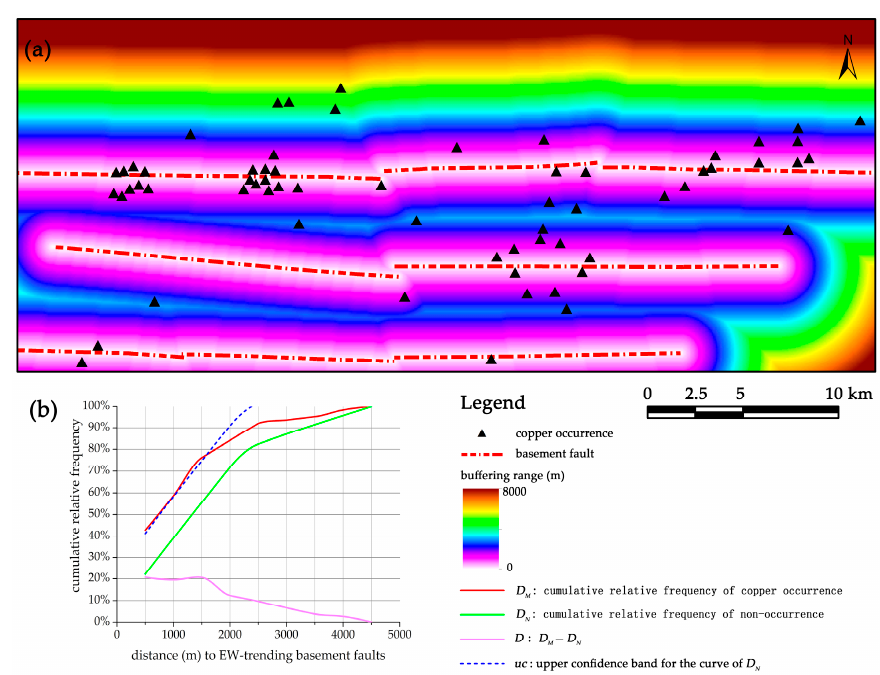
Figure 6. ( a ) Buffer analysis and ( b ) graph of cumulative relative frequency concerning distance to EW-trending faults. Minerals 2018 , 8 , x FOR PEER REVIEW